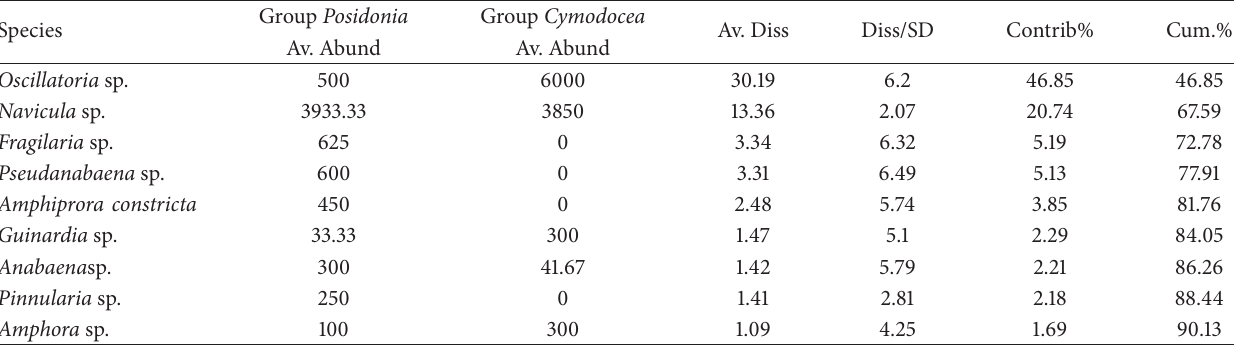
Table 2: SIMPER results.